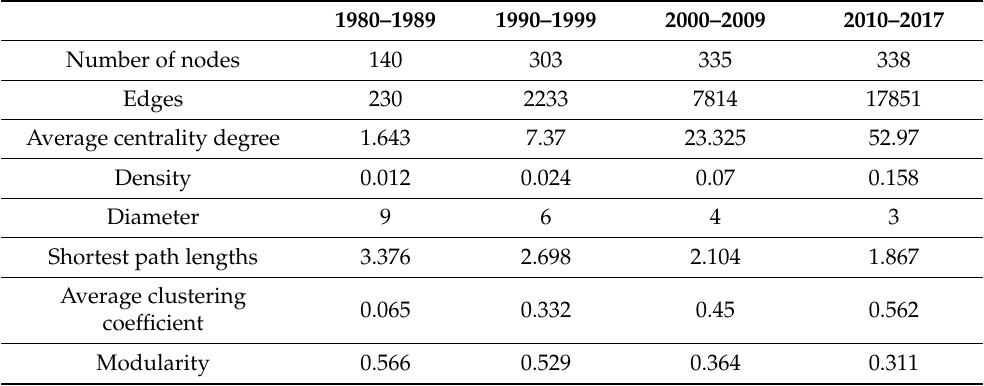
Table 2. Overall indicators of enterprise inter-city investment